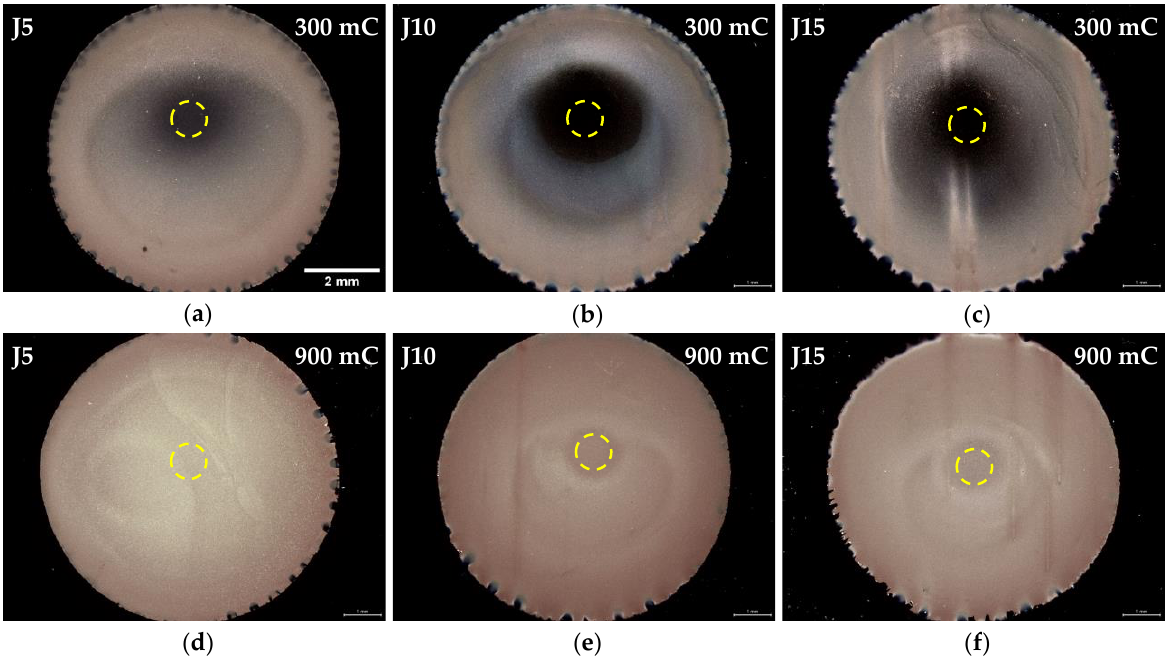
Figure 3. Digital microscopy images of the as-deposited Cu films at 5 ( a ), 10 ( b ), and 15 mA·cm −2 ( c ) for 300 mC and the same current densities ( d ), ( e ), and ( f ), respectively, for 900 mC, without electrolyte agitation.